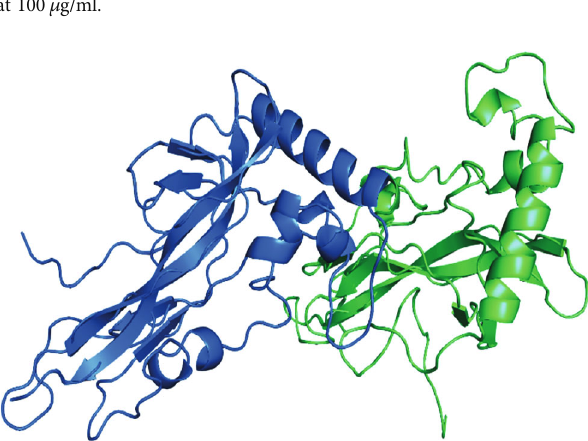
Figure 9: Coagulogen of Tachypleus tridentatus (pdb id: 1AOC) [41].